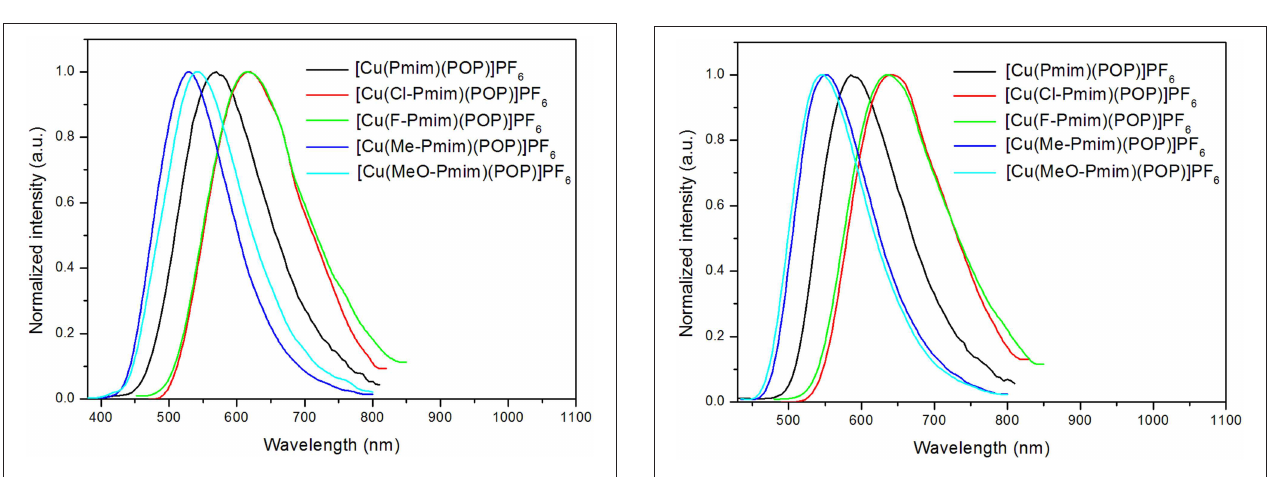
FIGURE 4 | Photoluminescence spectra of the Cu(I)-NHC complexes in solid state at room